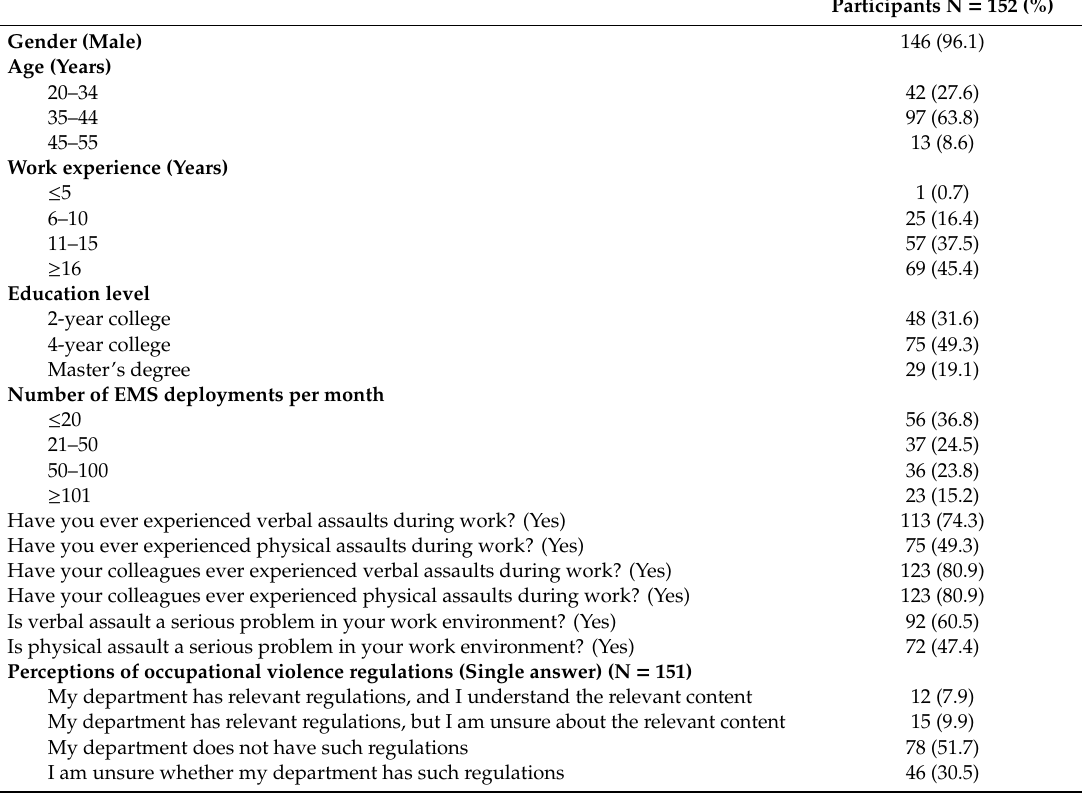
Table 1. Personal characteristics and work experience of the study